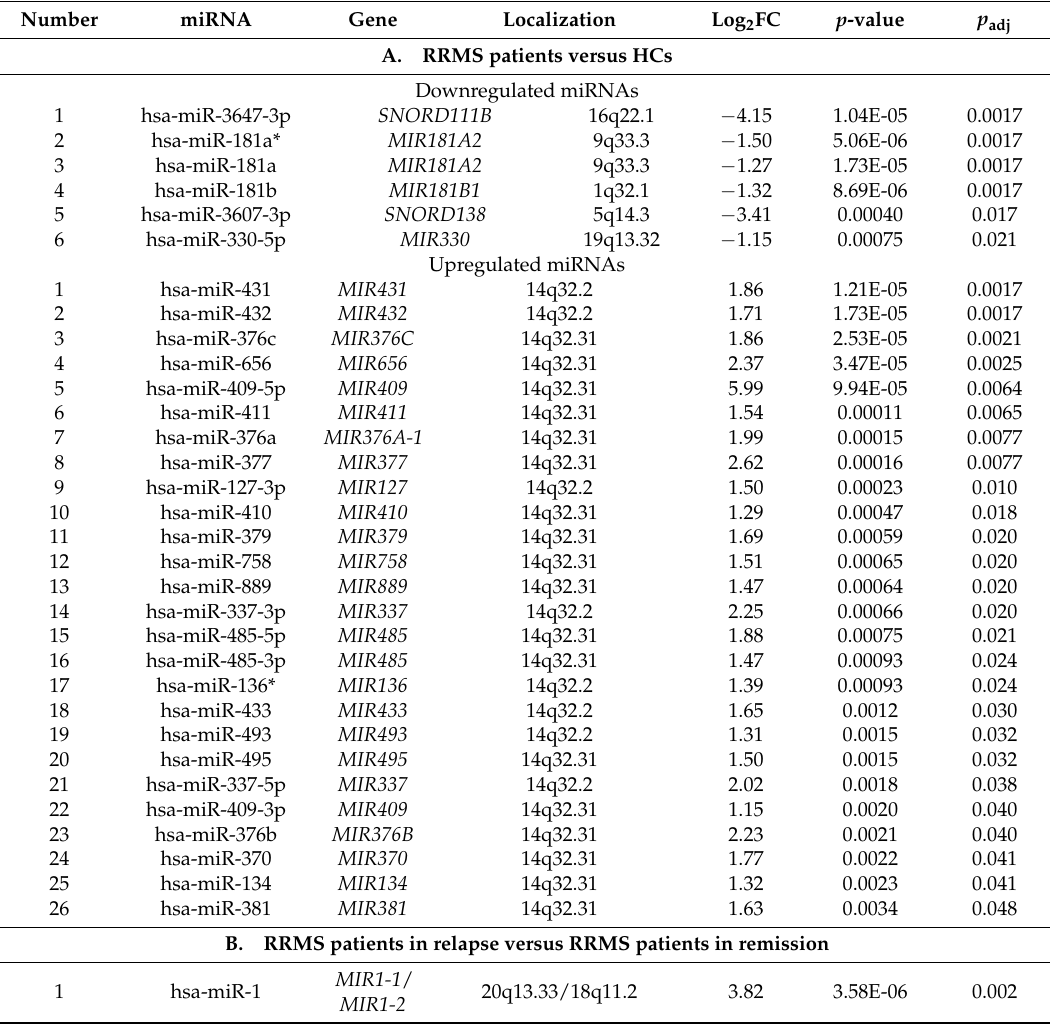
Table 2. MiRNAs, differentially expressed in male relapsing-remitting multiple sclerosis (RRMS) patients when compared to healthy controls (HCs) (A) and in RRMS patients in relapse when compared to RRMS patients in remission (B), identified using high-throughput